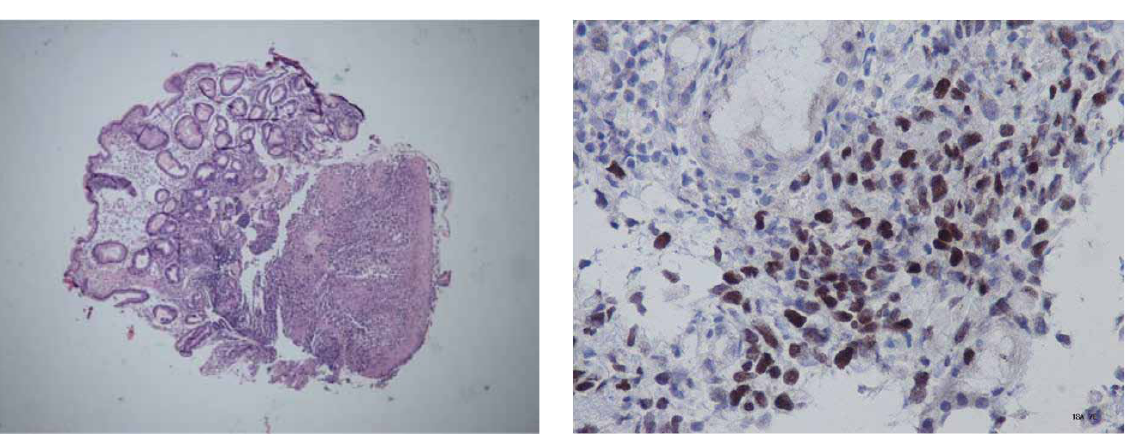
Figure 5. Metastatic deposit of the lung adenocarcinoma in the antrum